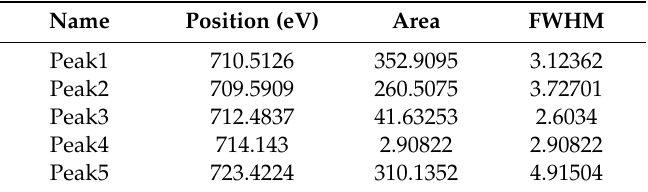
Table 1. Deconvoluted Gaussian peak parameters of peaks 1–5 from Figure 5b.